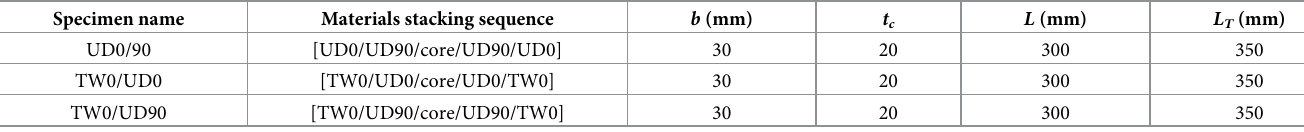
Table 2. Details of SHC beam specimens for a four-point loading flexural